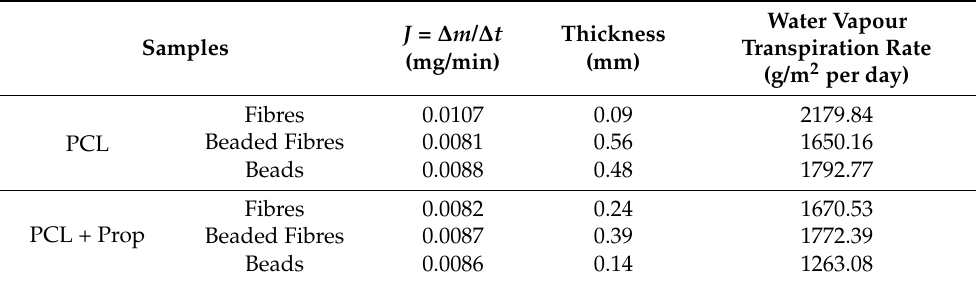
Figure 7. Water vapour flow (J) in electrospun mats with morphology variations. Table 4. Water vapour transpiration rate calculated for every sample with morphological variations from the water vapour flow ( J